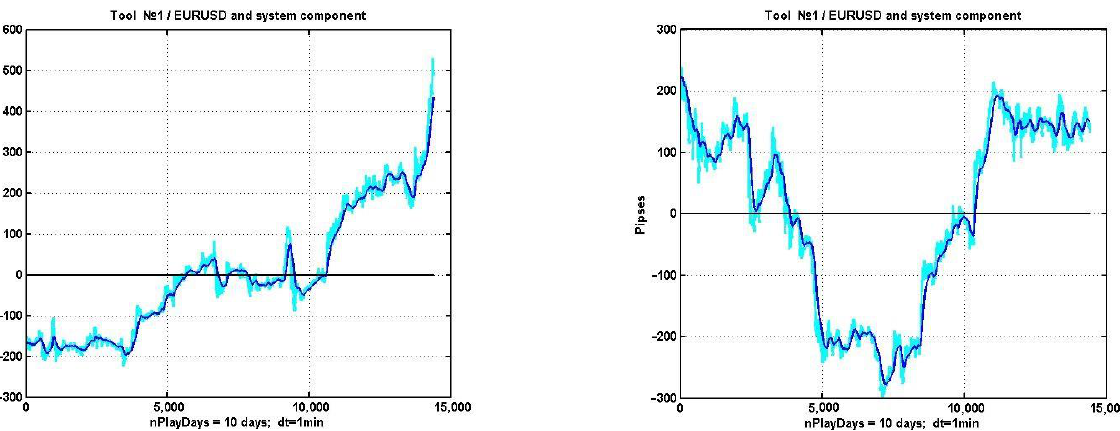
Figure 1. Two examples of observing the quotation of the EURUSD currency pair at two 10-day intervals with the system component identified by means of exponential filtering.